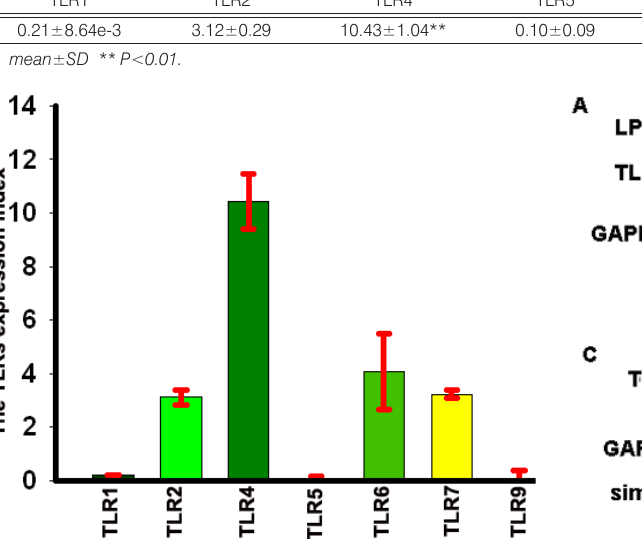
Figure 2. TLRs expression in RPMVECs. The expression of a variety of TLR family members in RPMVECs by qRT-PCR.